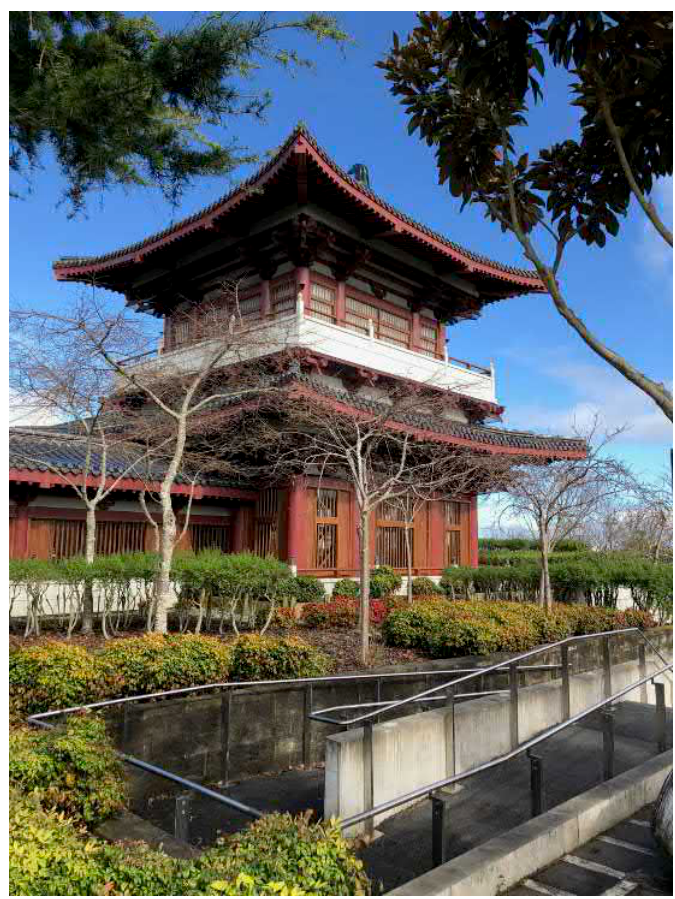
Figure 4: A part of the Fo Guang Shan Buddhist Temple complex in Auckland, 2018. (Photo by M. Mullins)